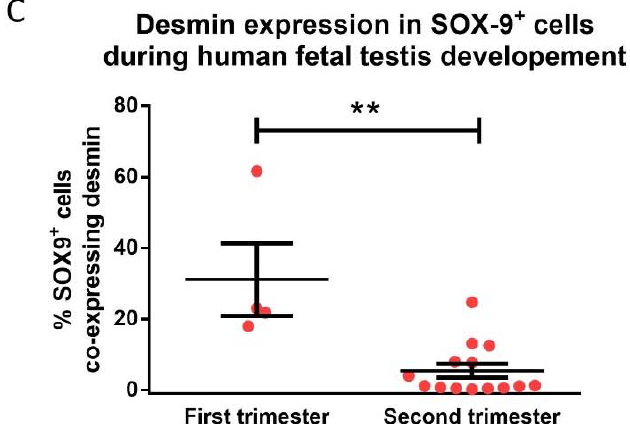
Figure 2. Desmin (red) and SOX-9 (green; Sertoli cells) expression in human fetal testis in first ( A ; 10 gestational weeks—GW) and second trimester ( B ; 18 GW) tissues. Yellow arrows: desmin + Sertoli cells, white arrows: desmin − Sertoli cells. Counterstained with DAPI (grey). C ) Desmin expression in SOX-9 + cells during human fetal testis development during the first trimester (8–13 GW, n = 4) and second trimester (14–20 GW, n = 14). Mean ± SEM, analysed by unpaired t -test. ** p < 0.01.